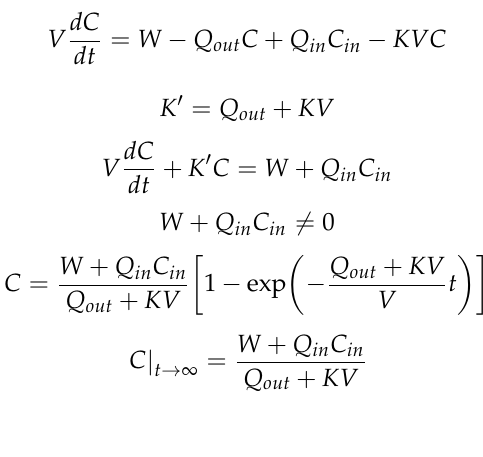
Figure 8. Zero-dimensional model schematic.